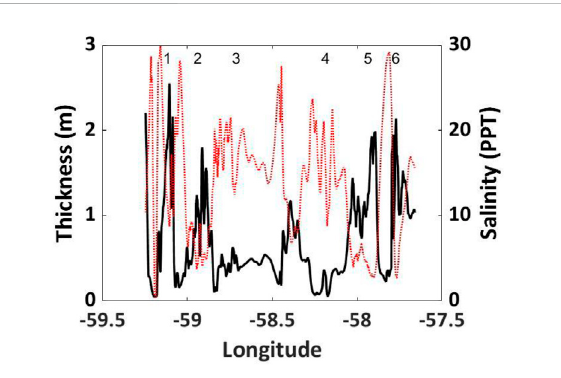
FIGURE 15 Retrieved basal temperature (dotted black line). Retrieved geothermal heat fl ux(GHF)(blue line). Red line is GHF from Martos et al. (2018). Black circles are average GHF values at the Camp Century, NEEM and NorthGRIP borehole sites taken from Martos etal.(2018).Heavyblack lineisthestrainheatingcorrected GHF (Jezek et al., 2022).